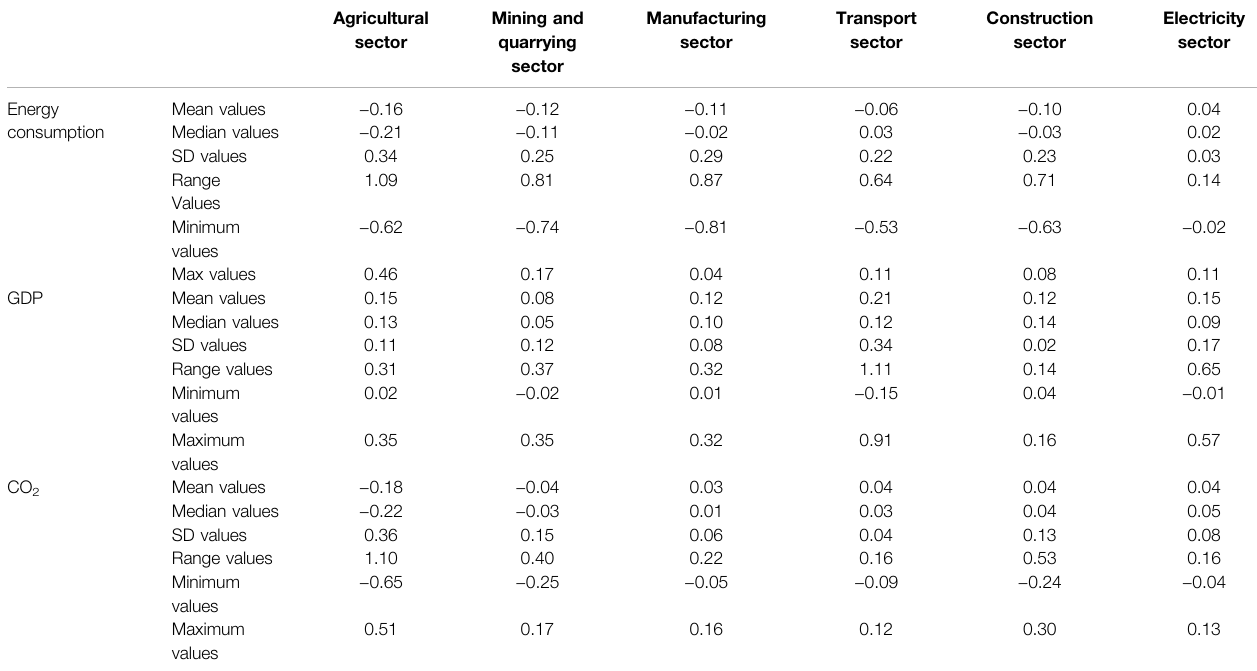
TABLE 1 | Growth rates (%) of descriptive statistics